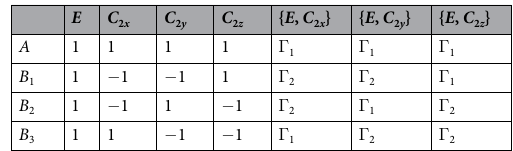
Figure 1. Crystal structure and electronic structure of the orthorhombic organic crystal C 6 H 7 ClO 3 . ( a ) Orthorhombic unit cell and single molecule of C 6 H 7 ClO 3 . Grey denotes carbon, red oxygen, blue hydrogen and green chlorine. ( b ) Brillouin zone path for band structure calculation. ( c ) Energy dispersion in around the R point. ( d ) Band structure and density of states. Crossings highlighted in green circles are 8-fold degenerate Dirac-points protected by crystalline symmetry and crossings in red circles are 4-fold degenerate Dirac points protected by band topology. ( e ) Energy dispersion along Γ X , Γ Y , Γ Z and irreducible representations.